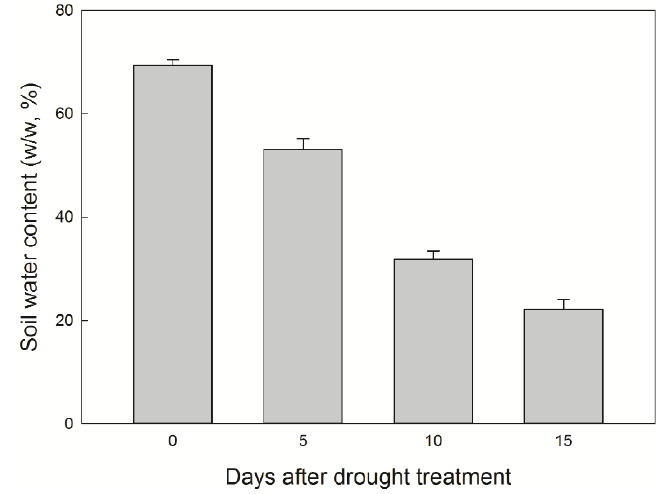
Figure 1. Soil water content under di ff erent drought duration. Each parameter is the average of three replicates.